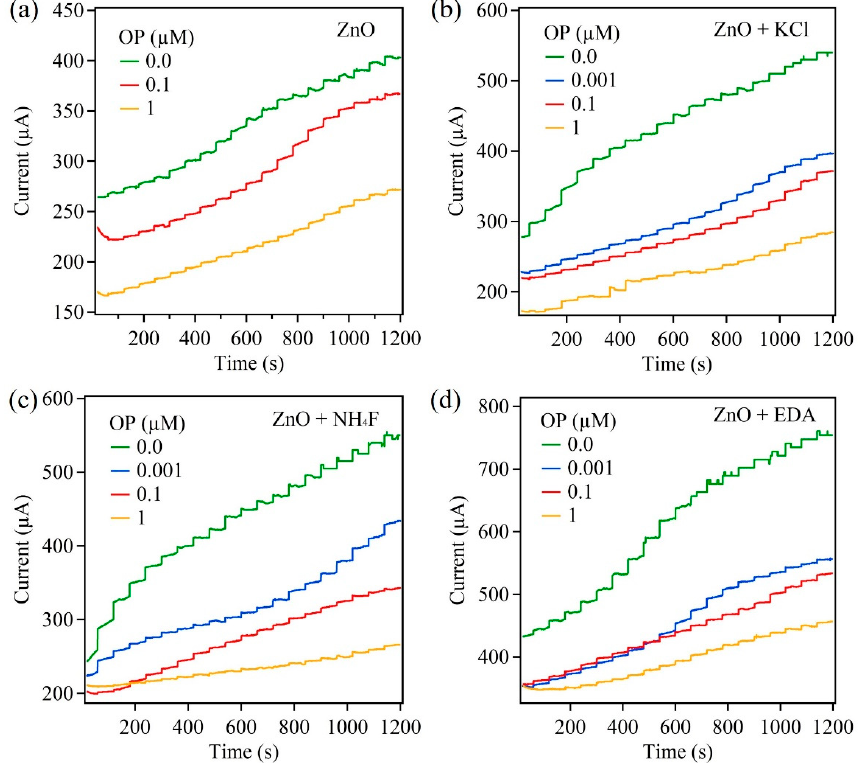
Figure 6. Amperometric response of ZnO samples on carbon cloth: ( a ) ZnO, ( b ) ZnO + KCl, ( c ) ZnO + NH 4 F, and ( d ) ZnO + EDA.